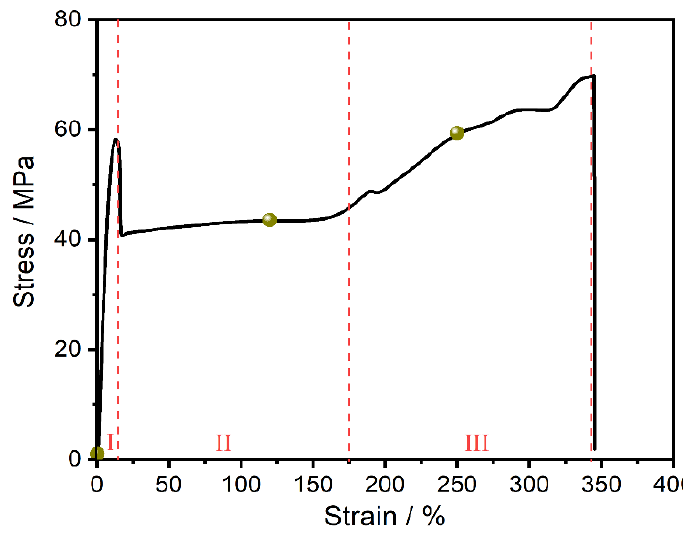
Figure 4. Engineering stress–strain curve of PAPACM12.